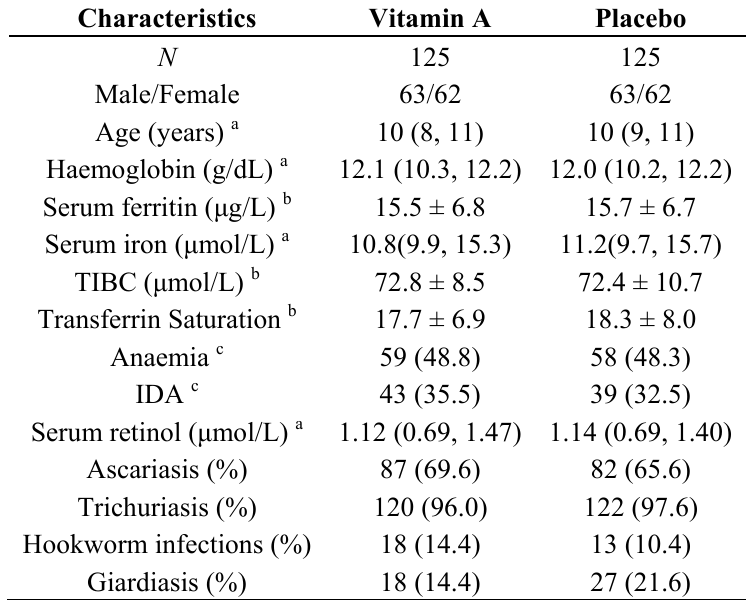
Table 1. Baseline characteristics of the intervention groups *. TIBC, total iron binding capacity; IDA, iron deficiency